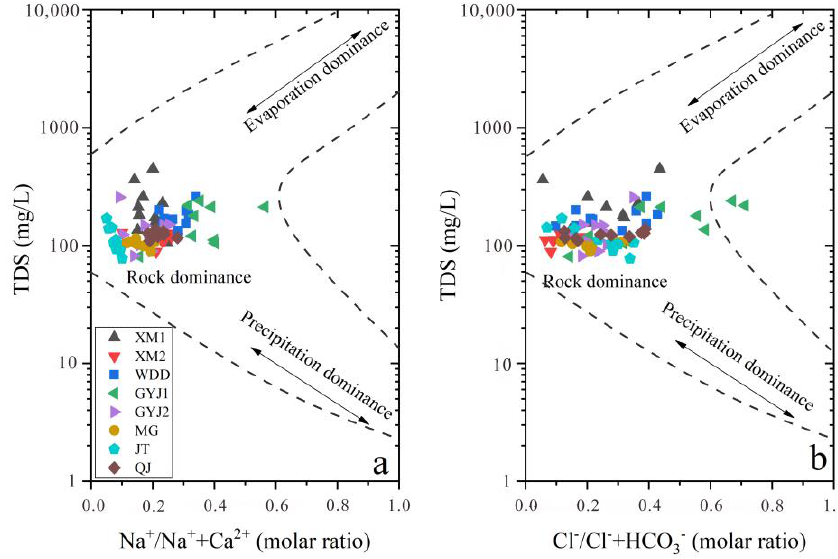
Figure 5. The Gibbs plots for chemical components in soil − soluble salt of soil profiles.